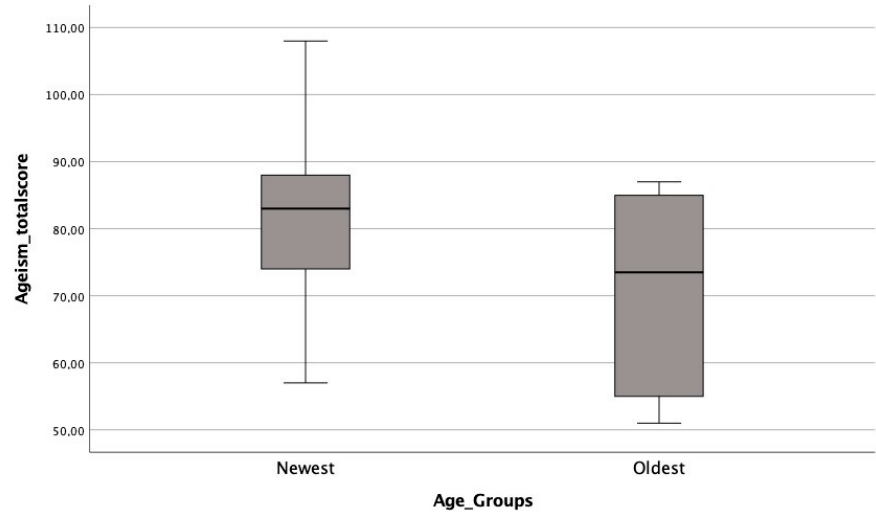
Figure 2. A box plot of the relationship between the total ageism score and the participants’ age .